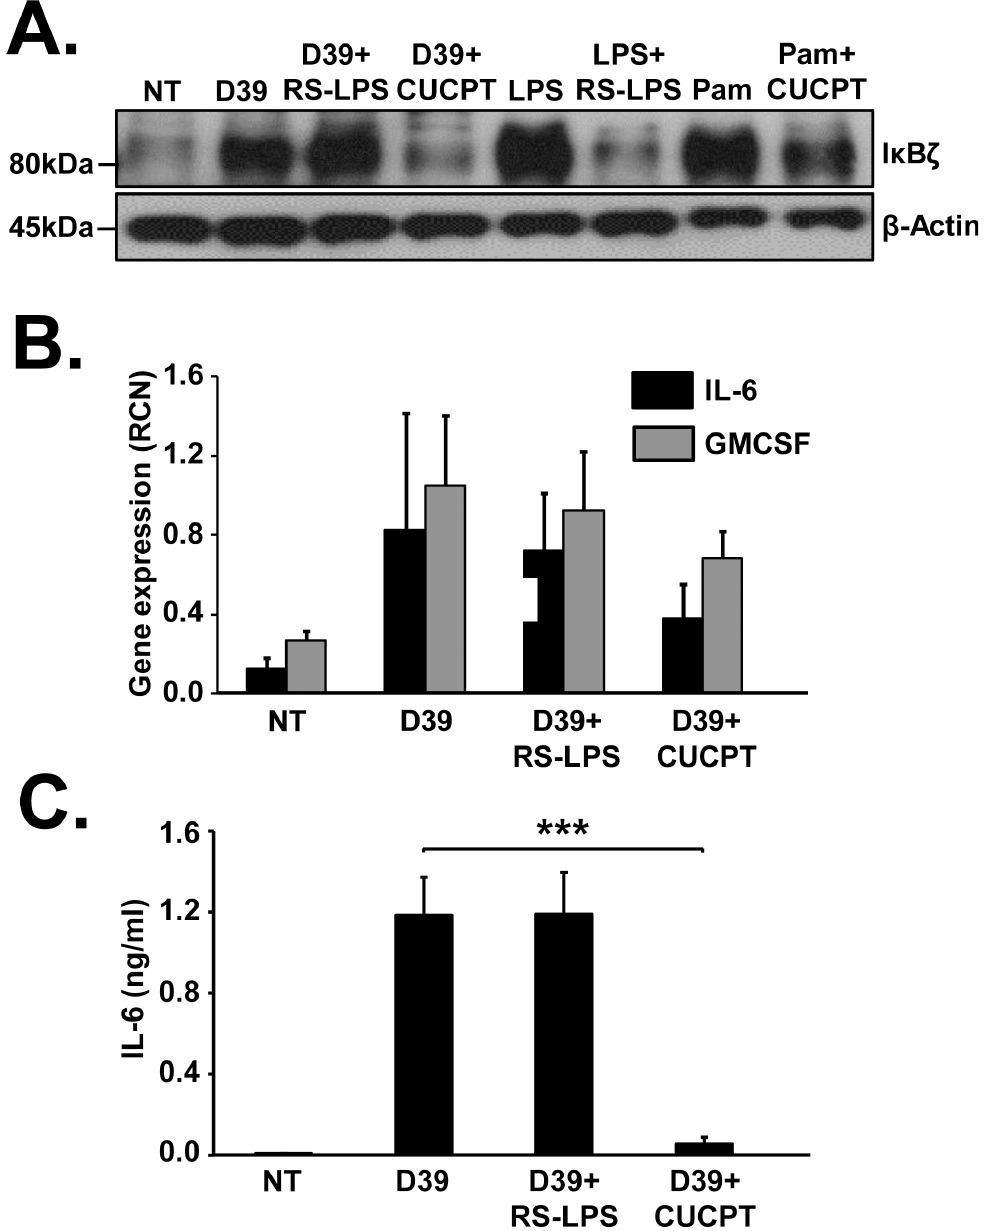
Fig 5. TLR1/TLR2 but not TLR4 blockade inhibits I κ B ζ induction. Human monocytes (10 6 cells/ml) were pretreated with RS-LPS (10 μ g/ml) or CUCPT22 (50uM) for 30 minutes followed by infection with D39 at an MOI of 0.1 for 3 and 6 h. LPS (10ng/ml) and PamCSK4 (Pam) (5ng/ml) were used as positive controls for TLR4 and TLR1/TLR2 induced I κ B ζ respectively. Cell extracts were analyzed (A) using immunoblotting for I κ B ζ and actin expression (B) using qPCR for mRNA expression. (C) IL-6 release from the cells was analyzed using ELISA. The immunoblot represents 4 – 5 independent experiments and the bar graphs represent the mean ± SEM of 4 – 5 independent experiments. *** p < 0.01. NT stands for not